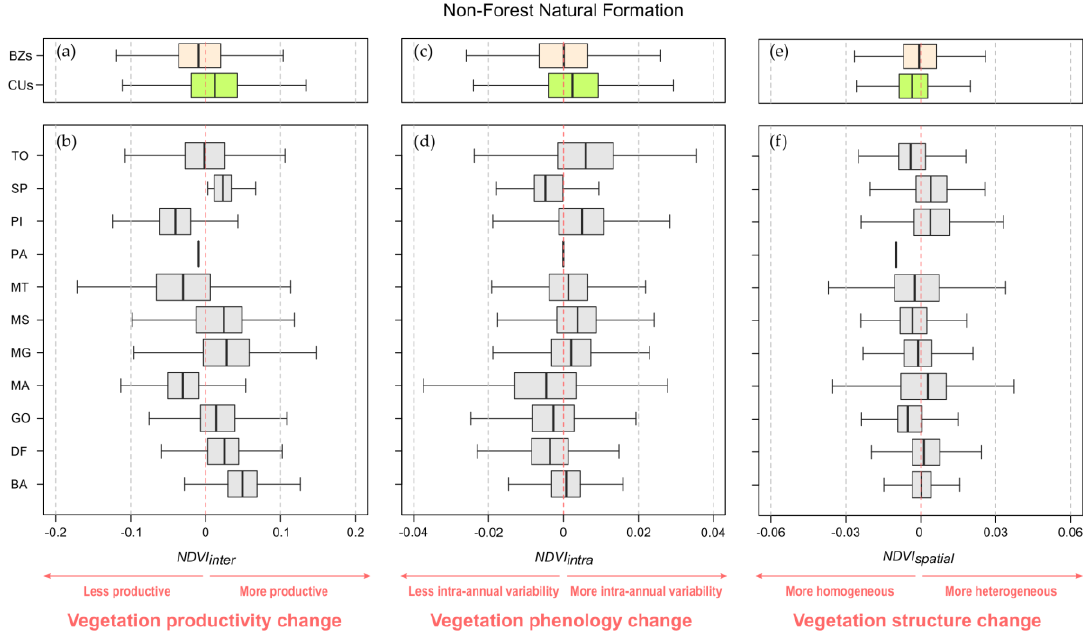
Figure E1. Boxplots of the landscape metrics’ values of the cells belonging to the ‘Non -Forest Natural Figure A2. Boxplots of the landscape metrics’ values of the cells belonging to the ‘Non-Forest Natural Formation’ category: ( a ) 𝑁𝐷𝑉𝐼 𝑖𝑛𝑡𝑒𝑟 in the buffer zones (BZs) and conservation units (CUs); Formation’ category: ( a ) NDVI inter in the bu ff er zones (BZs) and conservation units (CUs); ( b ) NDVI inter ( b ) 𝑁𝐷𝑉𝐼 𝑖𝑛𝑡𝑒𝑟 in each state; ( c ) 𝑁𝐷𝑉𝐼 𝑖𝑛𝑡𝑟𝑎 in the BZs and CUs; ( d ) 𝑁𝐷𝑉𝐼 𝑖𝑛𝑡𝑟𝑎 in each state; in each state; ( c ) NDVI intra in the BZs and CUs; ( d ) NDVI intra in each state; ( e ) NDVI spatial in the BZs ( e ) 𝑁𝐷𝑉𝐼 𝑠𝑝𝑎𝑡𝑖𝑎𝑙 in the BZs and CUs; (f) 𝑁𝐷𝑉𝐼 𝑠𝑝𝑎𝑡𝑖𝑎𝑙 in each state. Number of 250 m resolution (6.25 ha) and CUs; ( f) NDVI spatial in each state. Number of 250 m resolution (6.25 ha) cells located inside the 61 cells located inside the 61 conservation units = 77,430 and in their buffer zones = 42,286. Number of conservation units = 77,430 and in their bu ff er zones = 42,286. Number of cells in each Brazilian state cells in each Brazilian state with n > 0: Tocantins (TO, 47,905), São Paulo (SP, 39), Piauí (PI, 2302), Pará with n > 0: Tocantins (TO, 47,905), S ã o Paulo (SP, 39), Piau í (PI, 2302), Par á (PA, 1), Mato Grosso (MT, (PA, 1), Mato Grosso (MT, 7910), Mato Grosso do Sul (MS, 1198), Minas Gerais (MG, 11,902), 7910), Mato Grosso do Sul (MS, 1198), Minas Gerais (MG, 11,902), Maranh ã o (MA, 13,653), Goi á s (GO, Maranhão (MA, 13,653), Goiás (GO, 20,502), Distrito Federal (DF, 1691), Bahia (BA, 12,613). 20,502), Distrito Federal (DF, 1691), Bahia (BA,